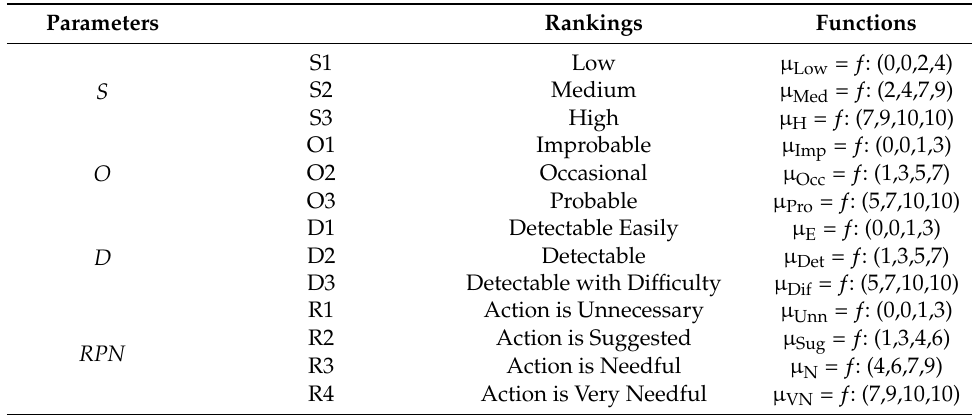
Figure 10. Membership function of risk priority number. Table 4. Membership functions of F-FMEA.